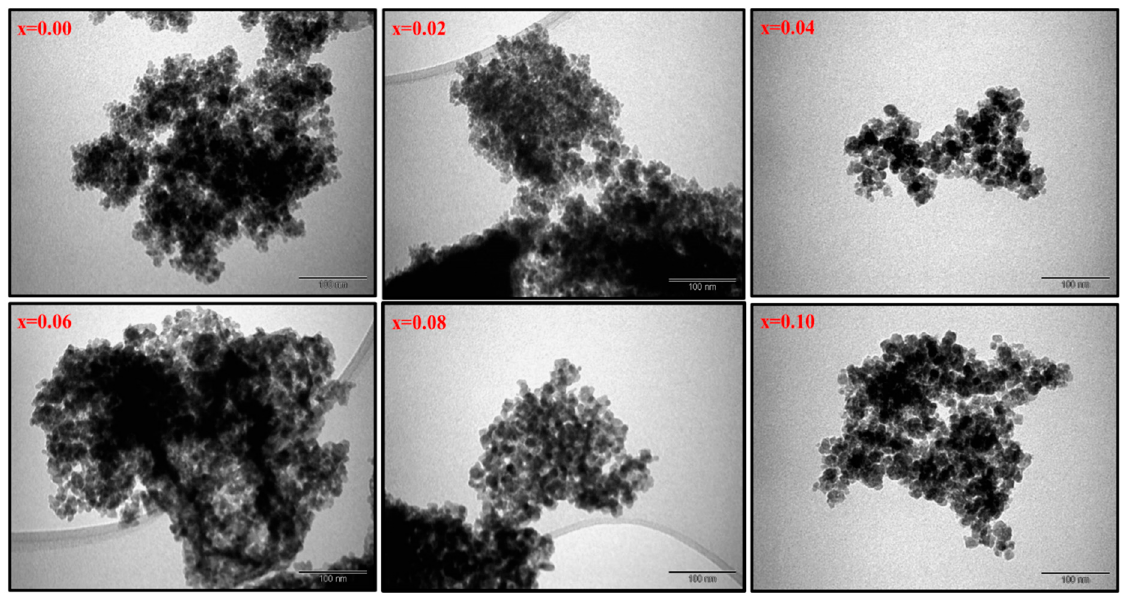
Figure 4. TEM images of Co 0.5 Ni 0.5 Ga x Fe 2-x O 4 (0.0 ≤ x ≤ 1.0) MCs.